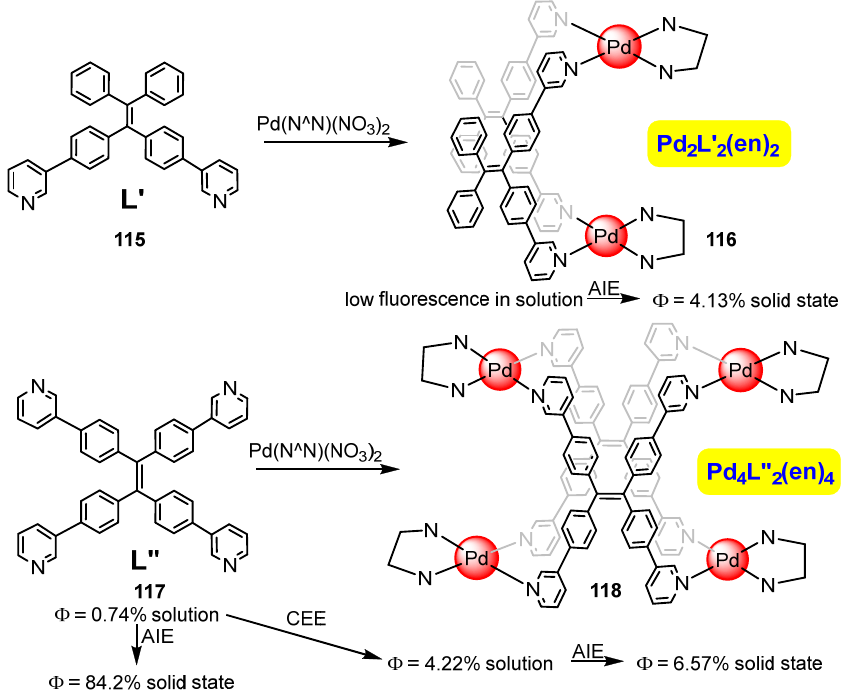
Figure 32. Pd 2 L ′ 2 (en) 2 and Pd 4 L ″ 2 (en) 4 built from polypyridine sca ff olds based on the TPE fragment. Figure 32. Pd 2 L (cid:48) 2 (en) 2 and Pd 4 L (cid:48)(cid:48) 2 (en) 4 built from polypyridine scaffolds based on the TPE fragment. Adapted from reference [108]. Adapted from reference